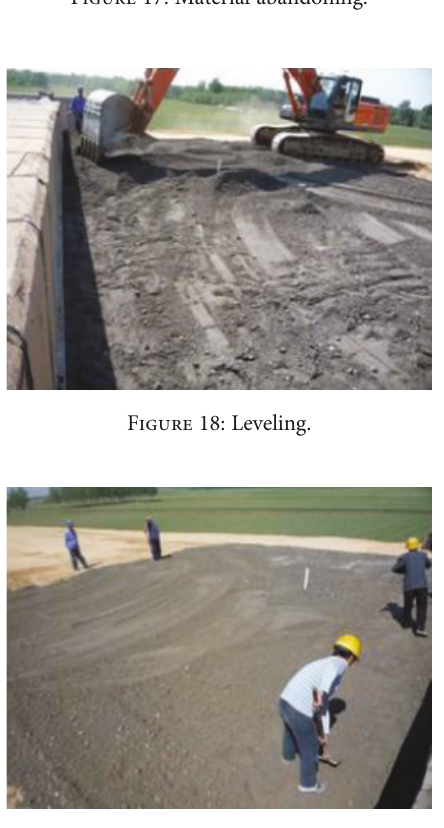
Figure 19: Smoothing.